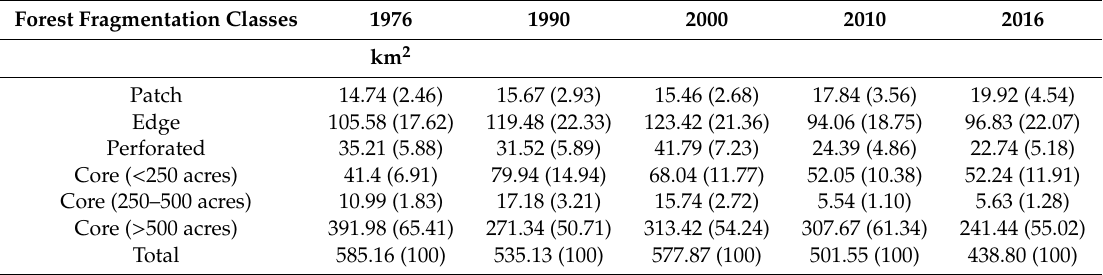
Table A3. Forest fragmentation results for 1976, 1990, 2000, 2010, and 2016 and percentage assessment based on satellite